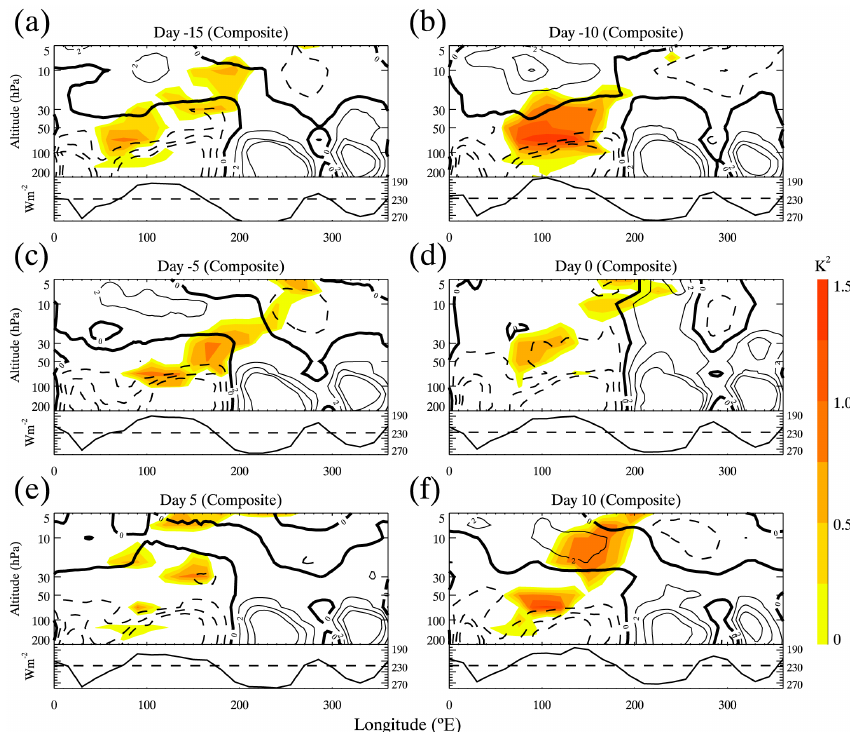
Figure 8. The longitude-altitude cross sections of Kelvin wave strength (color shades) shown only those corresponding to the significance level higher than 95%, zonal wind (black contours), and the longitudinal series of OLR (black solid lines) at day − 15 (a) , − 10 (b) , − 5 (c) , 0 (d) , 5 (e) , 10 (f) of the composite SSW event. All the characters above are averaged between 10 ◦ S and 10 ◦ N. The solid contours indicate eastward wind anomalies and the dashed ones indicate the westward shown in t value. Bold contours indicate the zero wind. The data are smoothed by a 5-day running mean. The dashed black lines indicate the 95% significance level of the averaged OLR of the composite